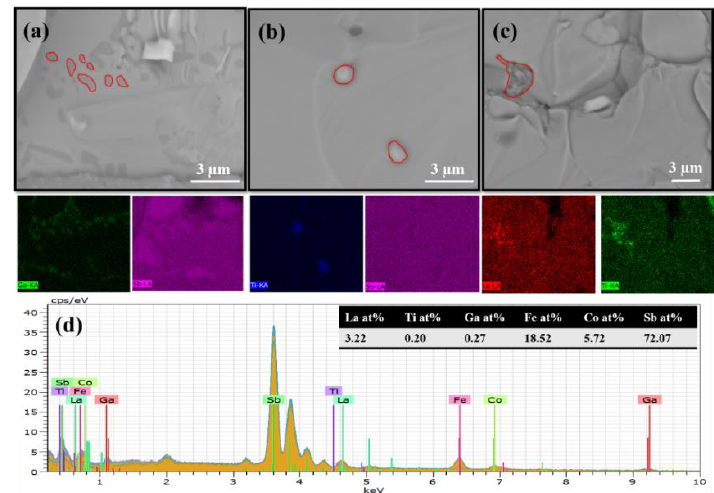
Figure 3. SEM image and elemental distribution of ( a ) GaSb precipitates, ( b ) TiSb 2 and ( c ) LaTi precipitates, and ( d ) EDS spectra of p-type La 0.7 Ti 0.1 Ga 0.1 Fe 2.7 Co 1.3 Sb 12 . Table 2. Nominal and measured compositions, density (ρ), electrical conductivity (σ), Seebeck coefficient (α), and total thermal conductivity ( κ total ) for n-type Yb 0.25 Fe 0.25 Co 3.75 Sb 12 and p-type